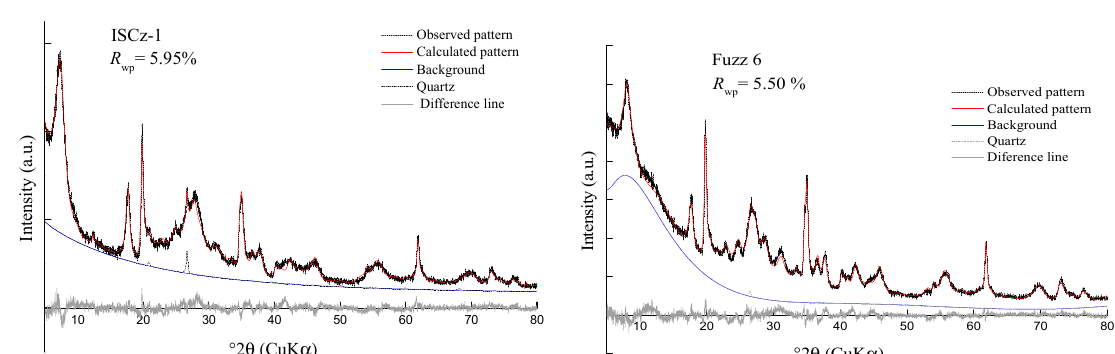
Figure 9. Rietveld refinements of powder diffraction patterns of samples ISCz-1 and Fuzz6.